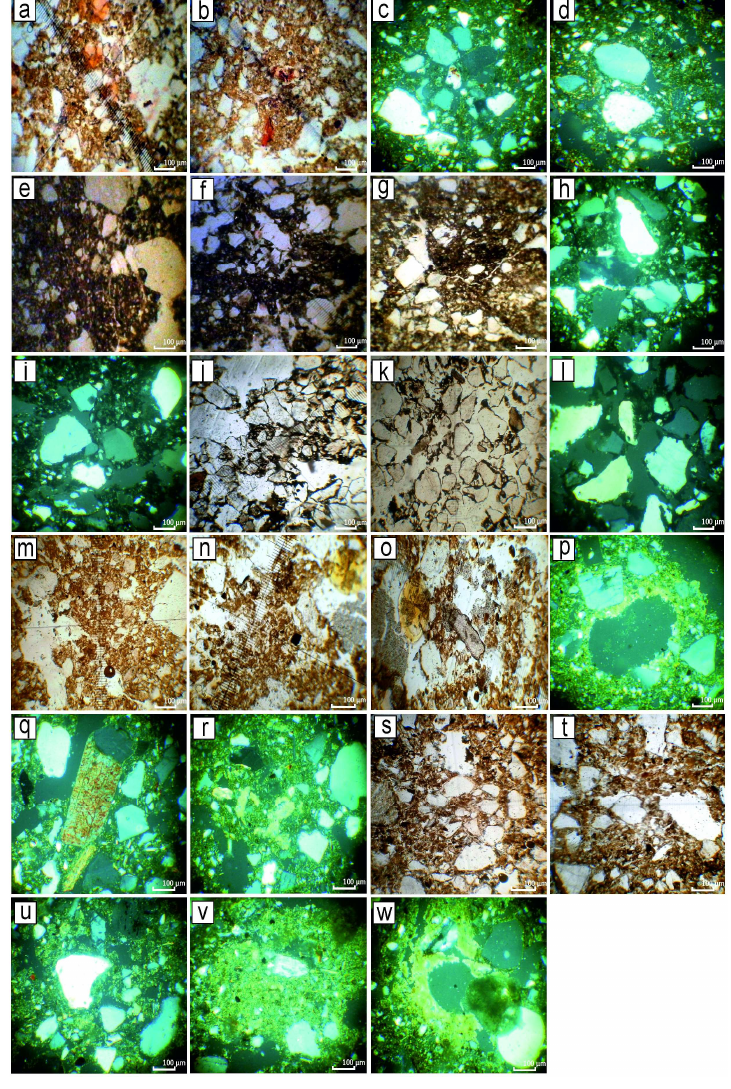
Figure 4. Kamyane-Zavallia. Soil micromorphology. Captions: see Supplementary Table S1. ( a , b , e – g , j , k , m – o , s , t )—PPL (plane-polarised light); ( c , d , h , i , l , p – r , u – w )—XPL (cross-polarized light). Magnification 1:70. Elaboration—ZM.